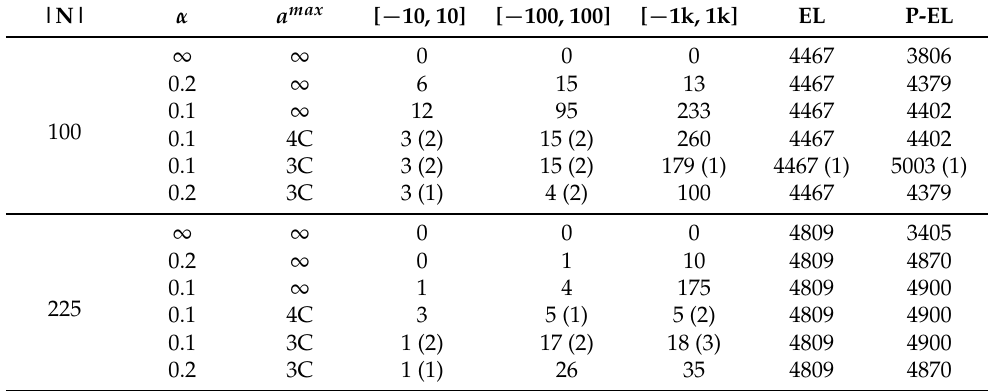
Table 9. Objective function value—values in round brackets indicate the number of unfeasible